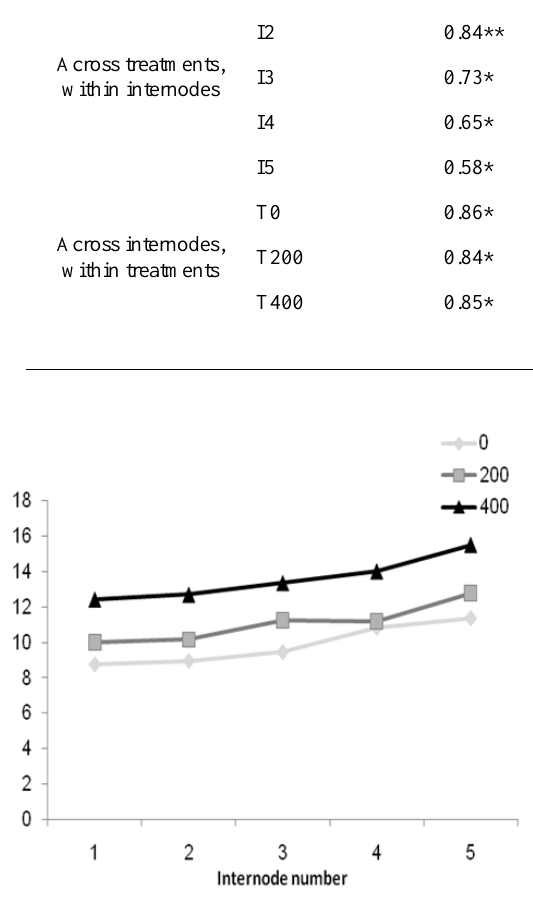
Fig. 3 . Change in lignin content under salt stress during internodal development. 1-5 Internode number from top; 1: upper and youngest internode and 5: lower internode. NaCl treatment: 0, 200 and 400 mM